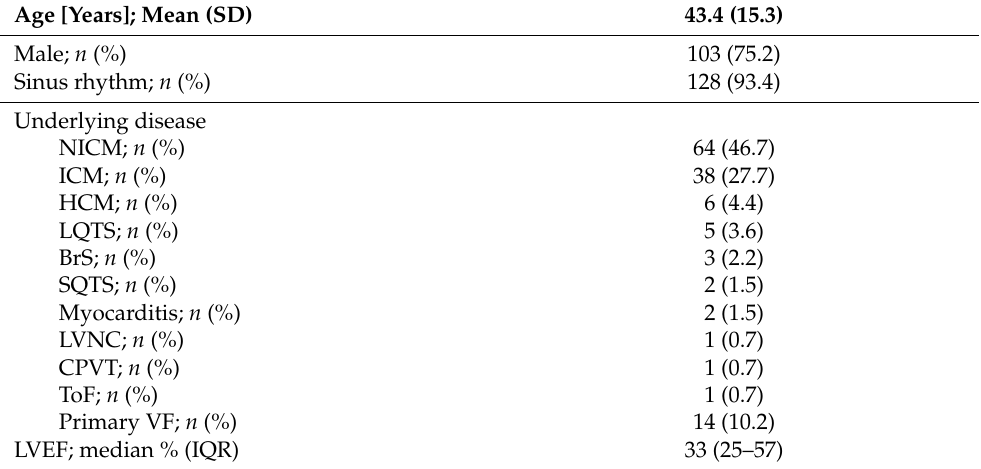
Table 1. Clinical characteristics of patients in the study